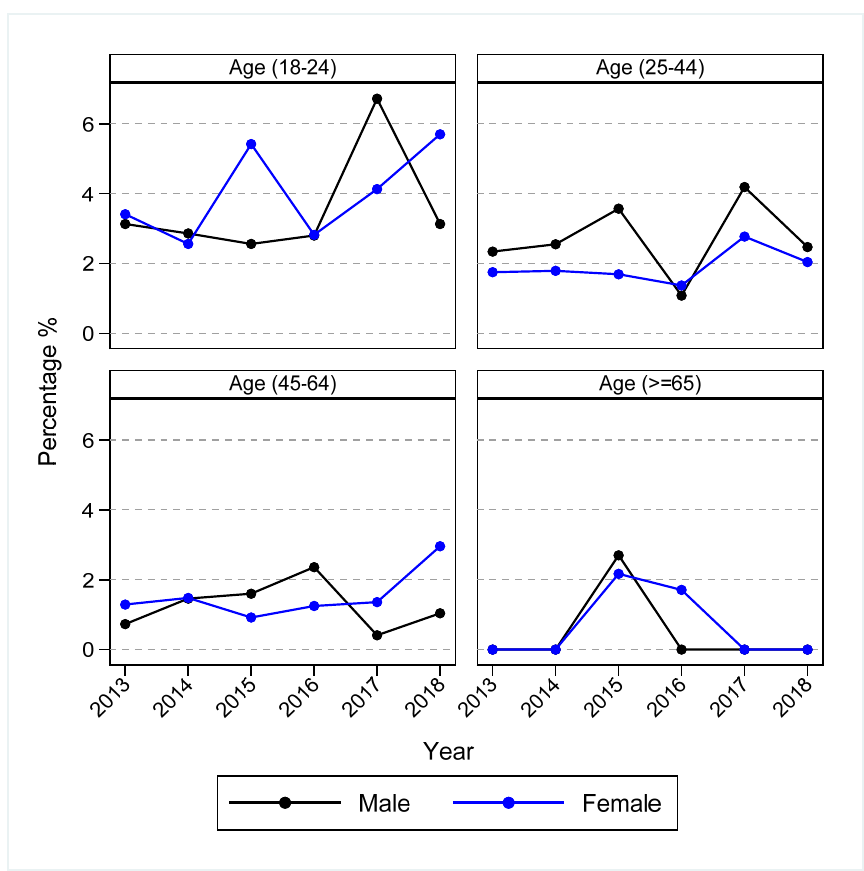
Figure 2. Trends in hospital-treated self-harm within 12 months of last service contact by sex and age group, Western Sydney Primary Health Network, 2013–2018. Any hospital treated self-harm presentation (including cases of undetermined intent) within 12-months of the last service contact (or referral date for referrals that did not result in at least one follow-up treatment session) was presented as a proportion of primary mental health care service referrals in each year.